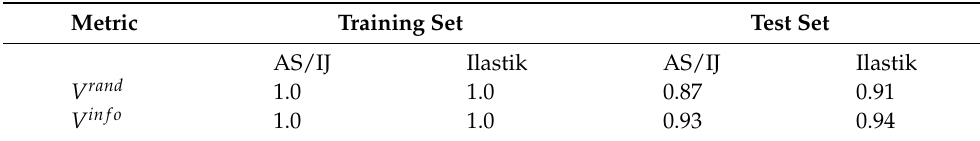
Table 7. Comparative performance of AS/IJ and Ilastik on the ISBI 2012 data set. Metric Training Set